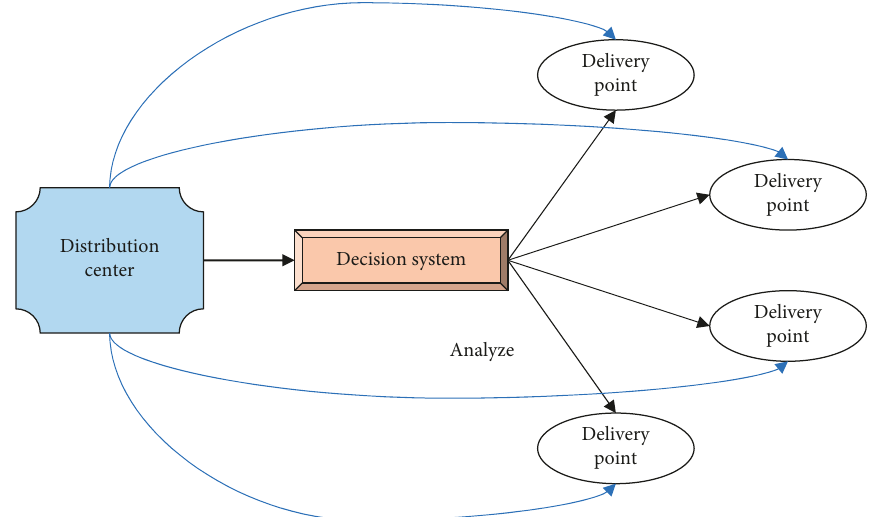
Figure 3: Principle of distribution